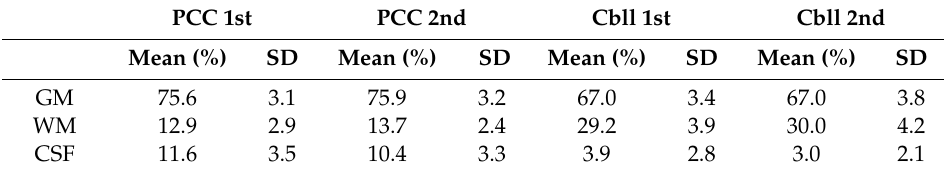
Table 3. Tissue compositions of